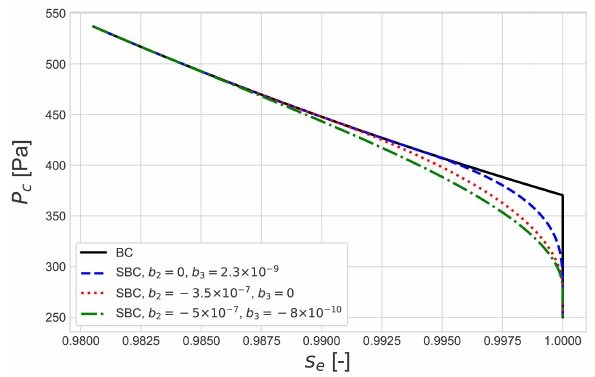
Figure A1. The Brooks–Corey water rendition curve for estimat- ing liquid saturation, s e , as a function of capillary pressure, P c , shown in solid black line and smooth approximation of Brooks– Corey (SBC) are shown in dashed